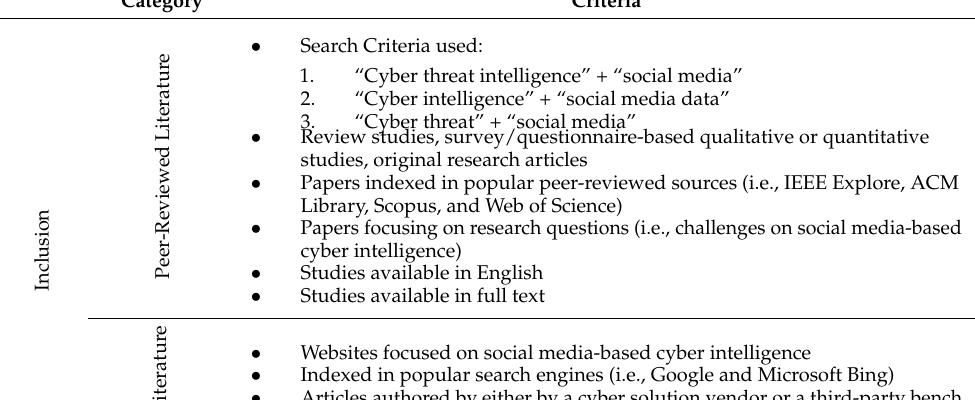
Table 1. Inclusion and exclusion criteria for both peer-reviewed and grey literature. Category